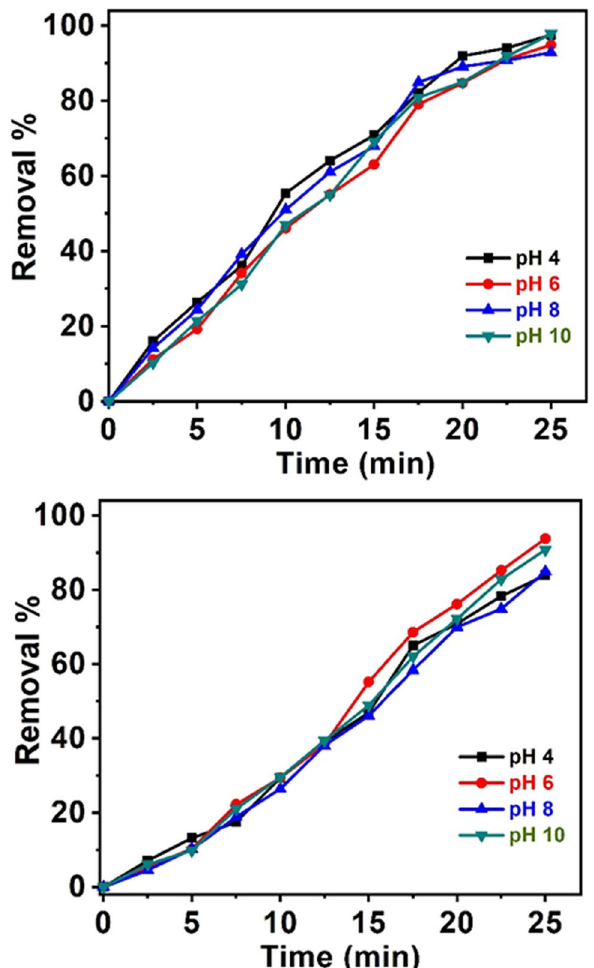
Figure 11. ( a ) pH effect on the bleaching process; ( b ) degradation efficiency of MO dye for 50 mg/L PCP- CNTs-Cu, MO 10